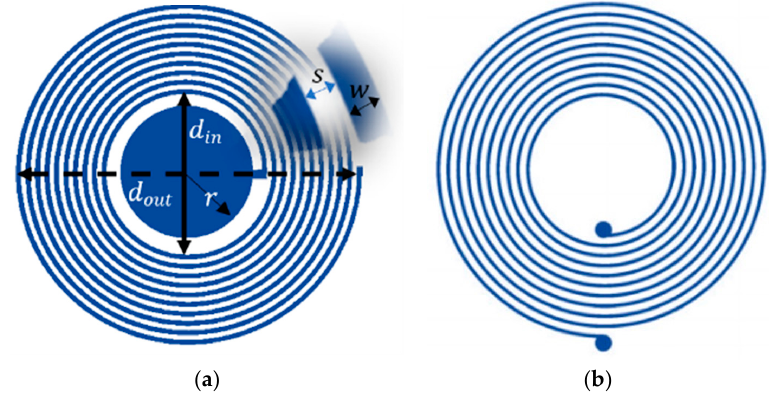
(cid:16) (cid:17) C pc and the substrate